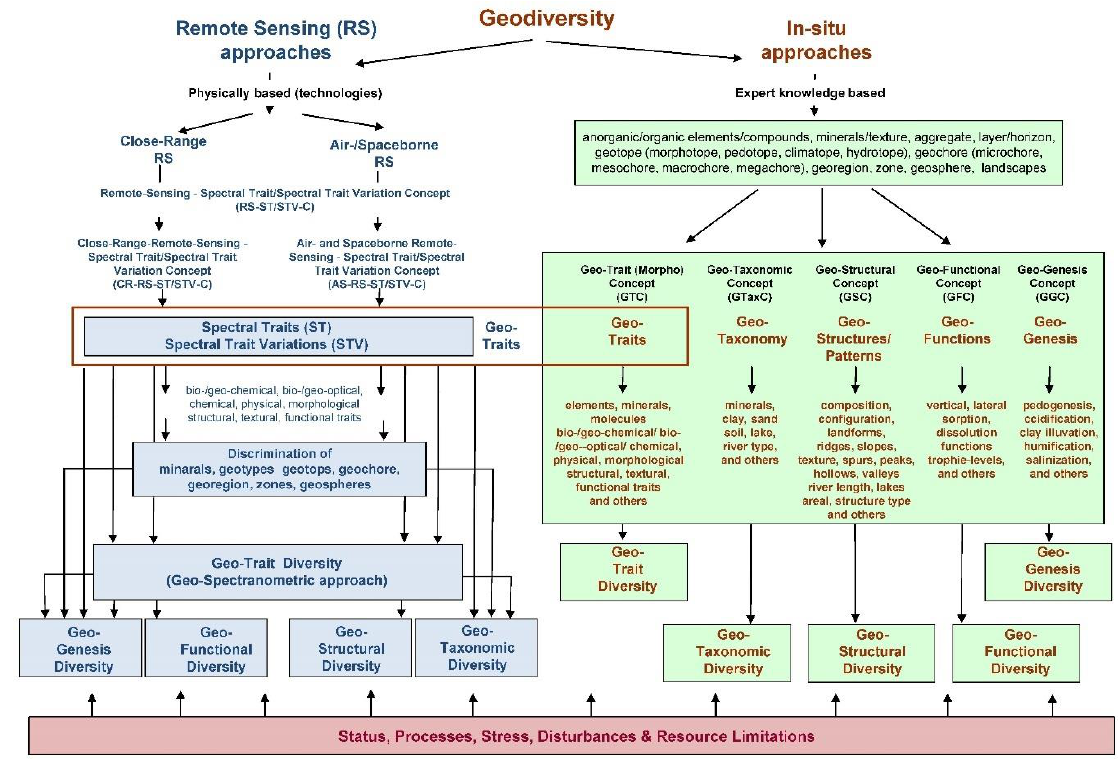
Figure 2. In-situ and remote sensing approaches to monitor geodiversity and their characteristics by remote sensing and in-situ approaches (modified after Lausch et al. [57]).